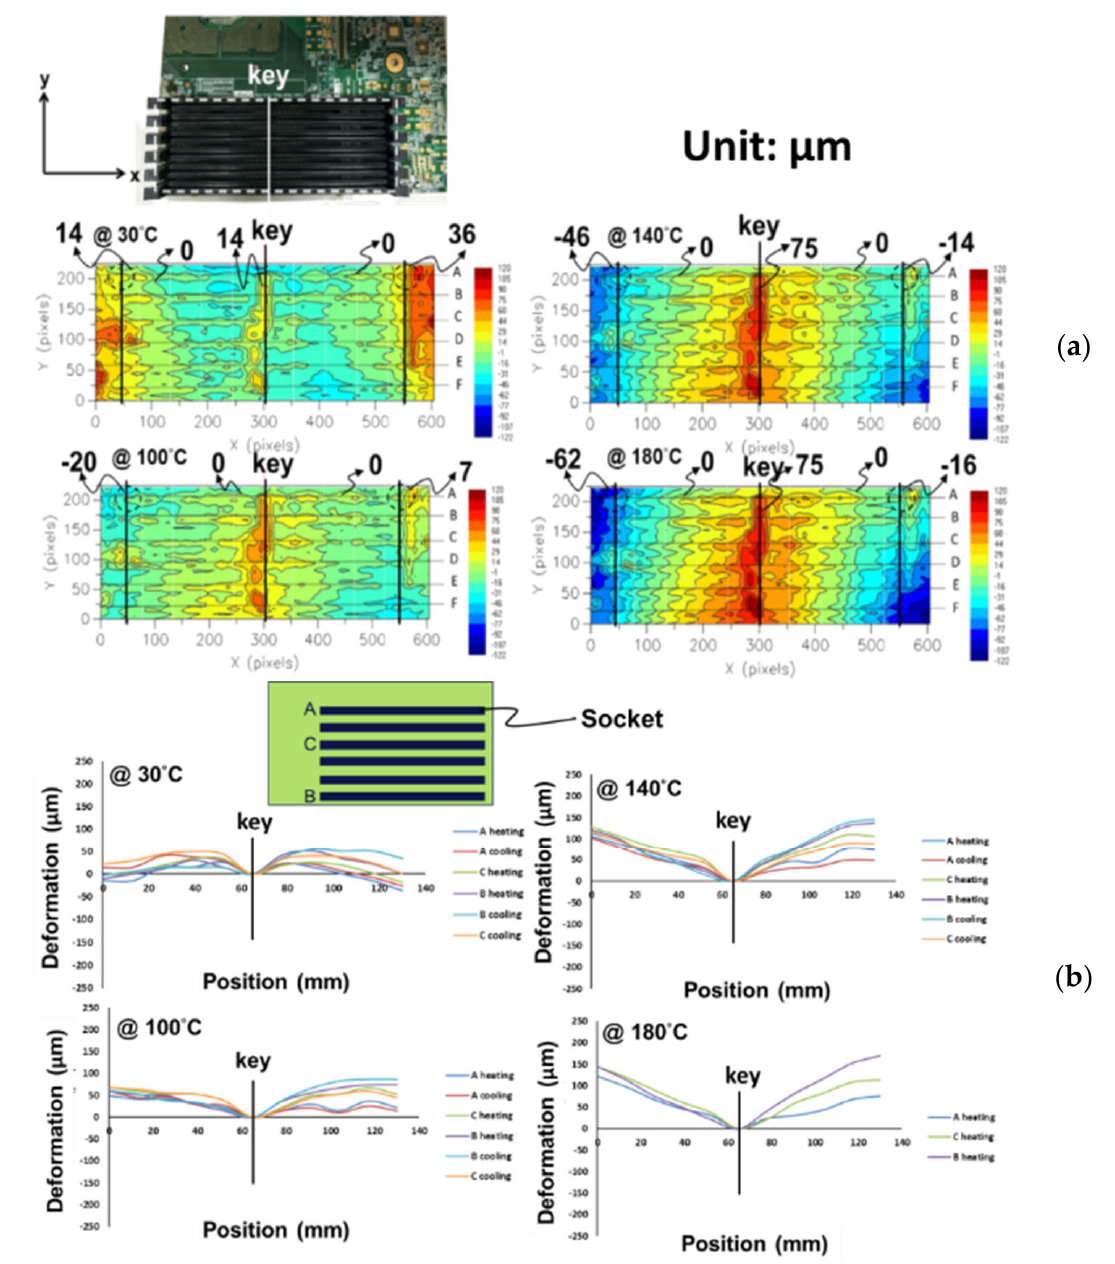
Figure 17. ( a ) Out-of-plane deformation contours (in dotted line box) for the six-socket-PCB assembly at various temperatures, obtained from moiré measurements, and ( b ) out-of-plane deformations of the socket-PCB assembly along the lines in which the sockets are located.